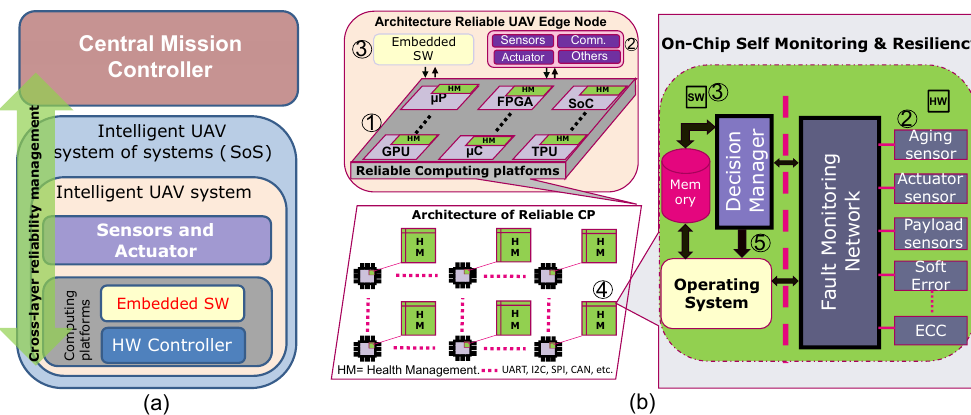
Figure 6. Cross-layer reliability model. ( a ) Cross-layer reliability modeling at different layers of UAV system. ( b ) System architecture of reliable UAV edge node, computing platforms, and on-chip health monitoring